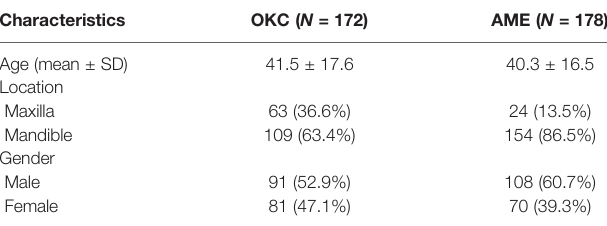
TABLE 1 | Demographic data of the study